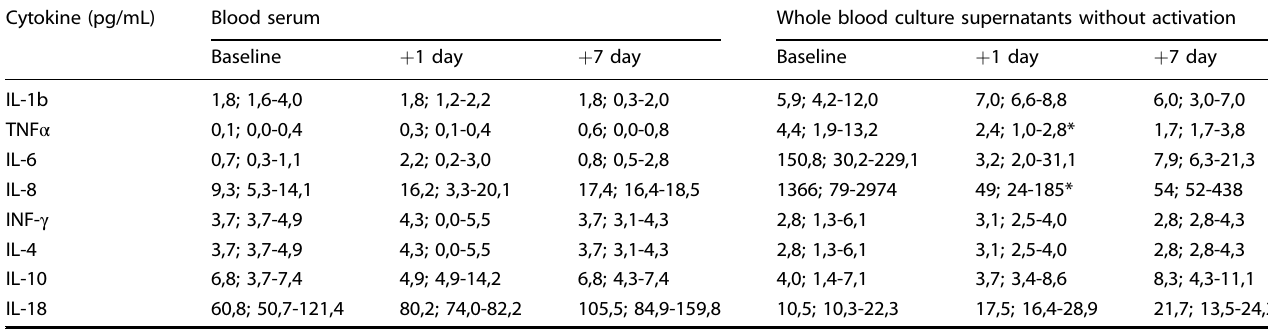
Table 2. Cytokine levels in serum and culture supernatants in the dynamics of pre- and post fl ight examinations of cosmonauts (median; q25 – q75), p values were obtained using the Wilcoxon ’ s